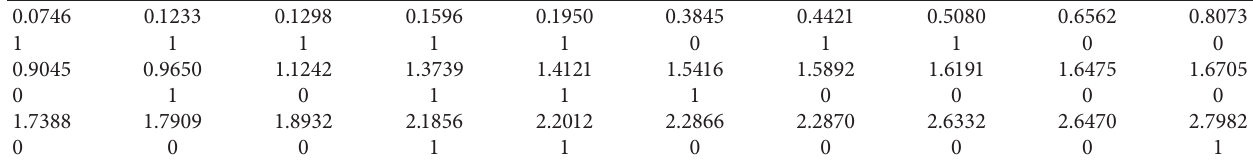
Table 4: The generated data under accelerated